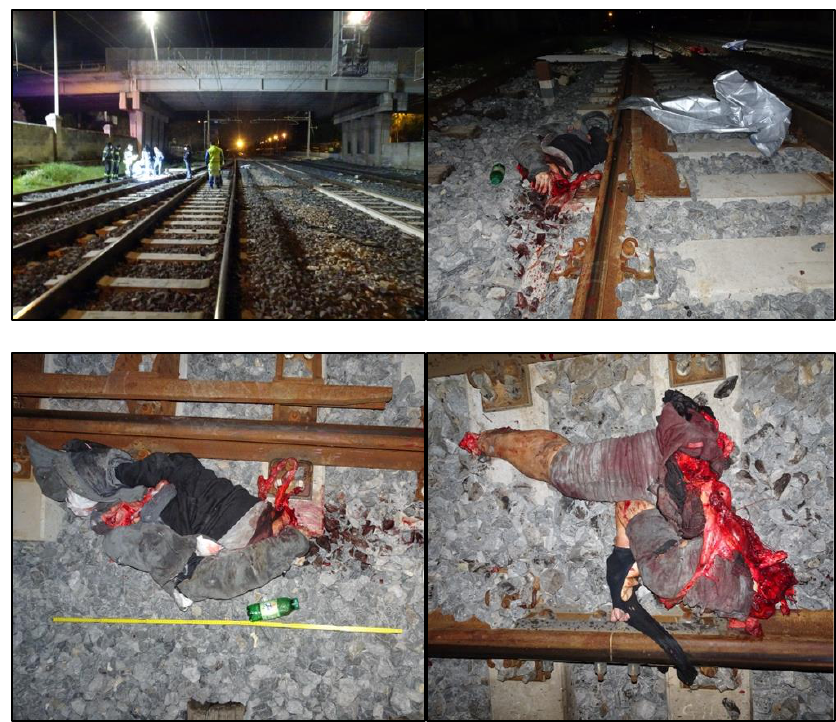
Figure 1. The railroad track where the investment occurred, with the man’s body segments lying near the impact point.